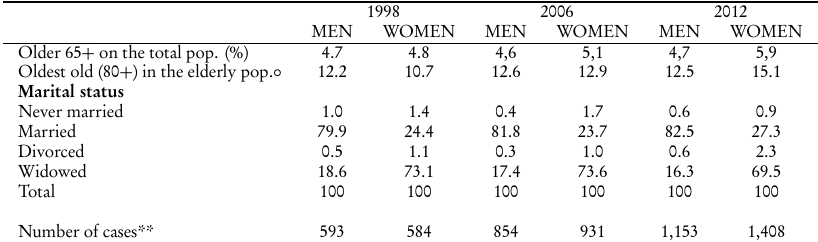
Socio-demographic characteristics of older Egyptians (65 years and over) by selected variables. Notes: ◦ Do you have any longstanding illness / chronic diseases (q1404)?; ** By applying the expansion factor, we obtained estimates of the number of older people (65 and over) in the total Egyptian population: these were 2,561,384 in 2008; 3,422,059 in 2006; and 4,235,647 in 2012. Weighted data. Source: Angeli,